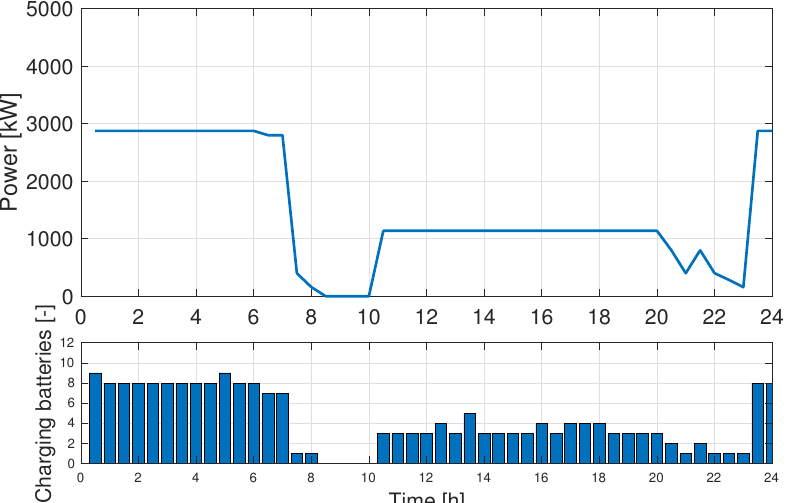
Figure 15. Power consumption (top) and battery charging schedule (bottom) at LGAV for the average day case (400 kW chargers).